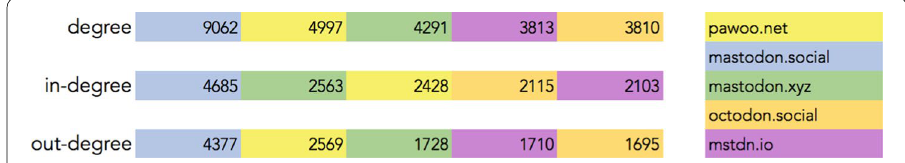
Fig. 4 Top-5 instances by degree, in-degree, and out-degree, respectively, in the I nstancEs